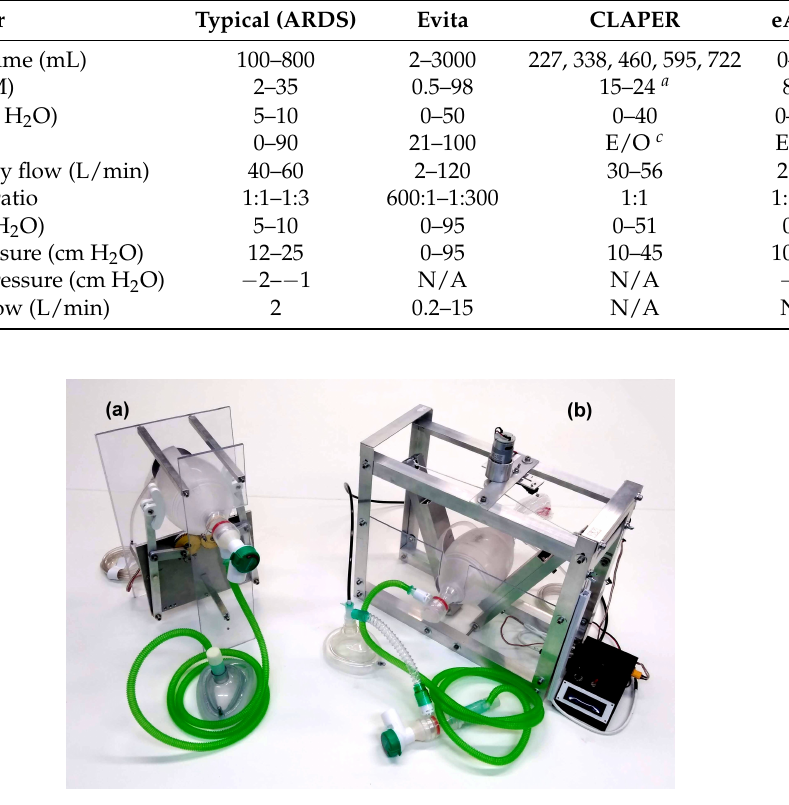
Figure 6. Photograph of the CLAPER ( a ) and eARM ( b ) prototypes